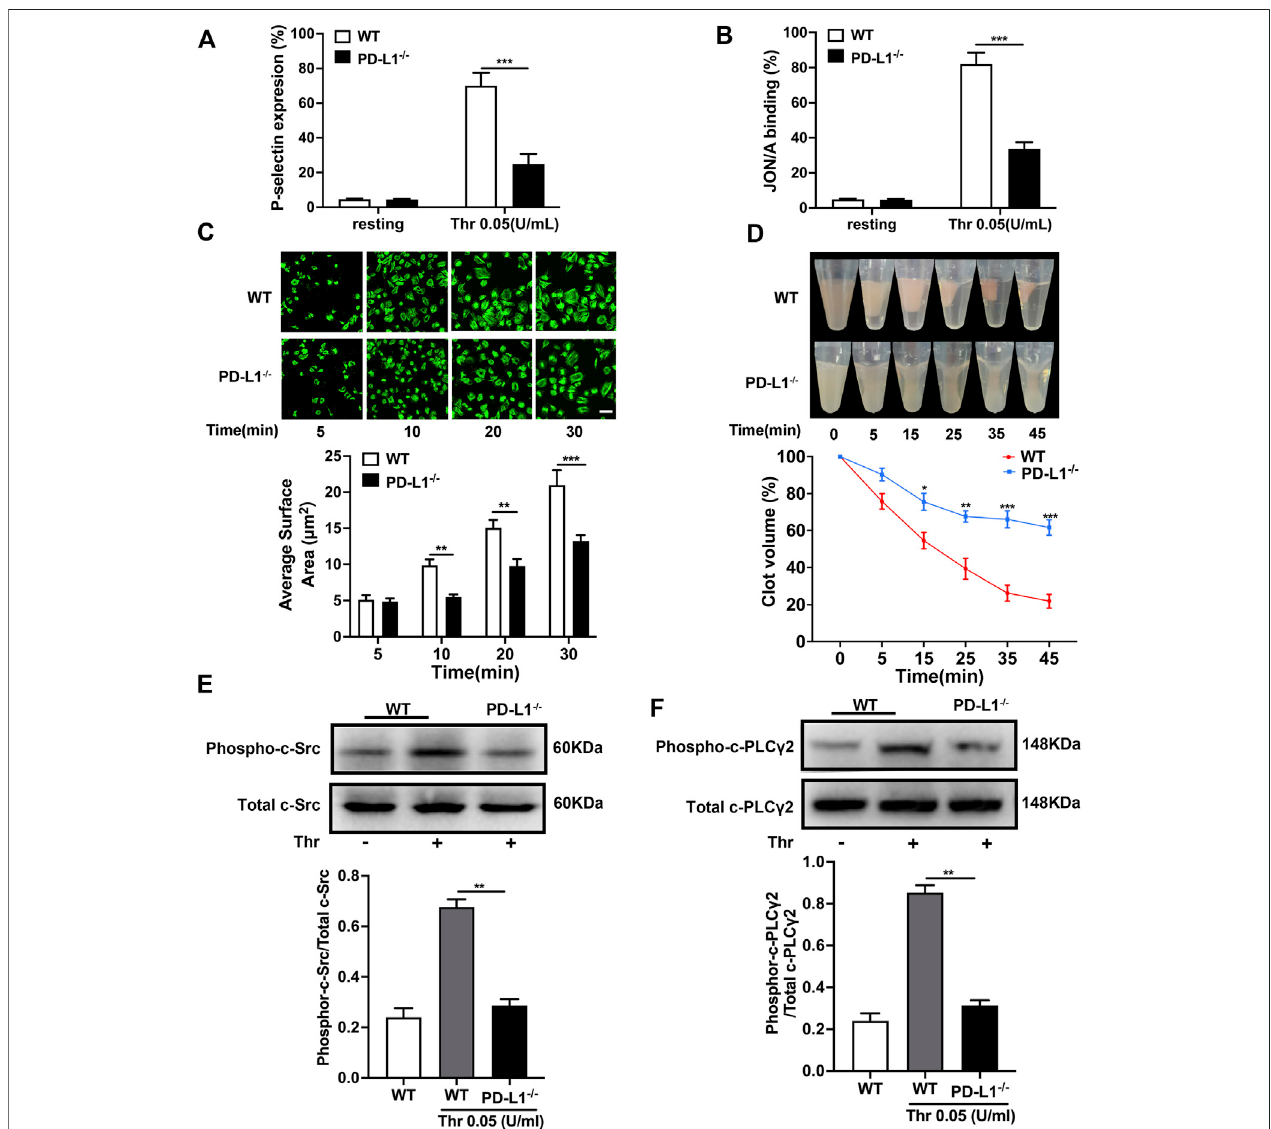
FIGURE3| PD-L1knockoutinhibitesplateletintegrin α IIb β 3outside-insignaling. (A) FlowcytometryanalysisofFITC-CD62Pbindingtorestingplateletsorplatelets stimulatedwiththrombin(0.05U/mL)for5 min. (B) FlowcytometryanalysisofPE-JON/Abindingtorestingplateletsorplateletsstimulatedwiththrombin(0.05U/mL)for 5 min. (C) Washed platelets were allowed to adhere and spread on fi brinogen-coated wells by thrombin (0.05 U/mL) stimulation at 37 ° C for 5, 10, 20, 30 min. The spreadingareaofsingleplateletwasmeasuredusingImageJ2xsoftware,withpixelnumberastheunitofsize. (D) Clotretractionwasmeasured for45 mininPRP, after adding 0.25 U/mL of thrombin and incubation at 37 ° C. Washed platelets in modi fi ed thyroid ’ s buffer were mixed with 100 μ g/ml puri fi ed human fi brinogen. (E) Representatives immunoblot of the phosphorylation of c-Src in platelet from WT mice and PD-L1 − / − mice. (F) Representatives immunoblot of the phosphorylation of PLC γ 2 in platelet from WT mice and PD-L1 − / − mice. Data are mean ± SD; n = 5. * p < 0.05, ** p < 0.01, *** p <